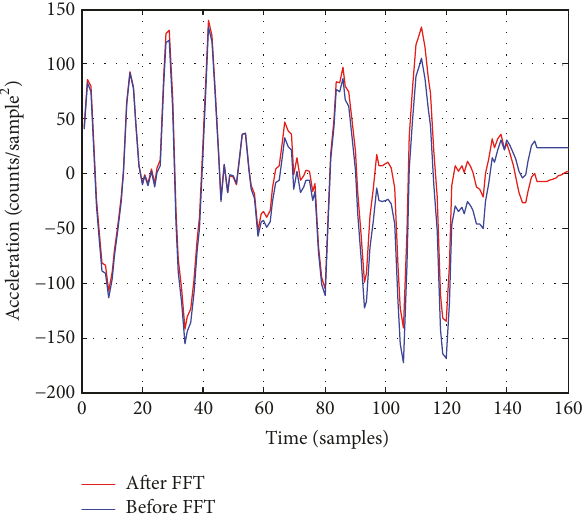
Figure 10: The waveforms of the acceleration before FFT and after FFT.